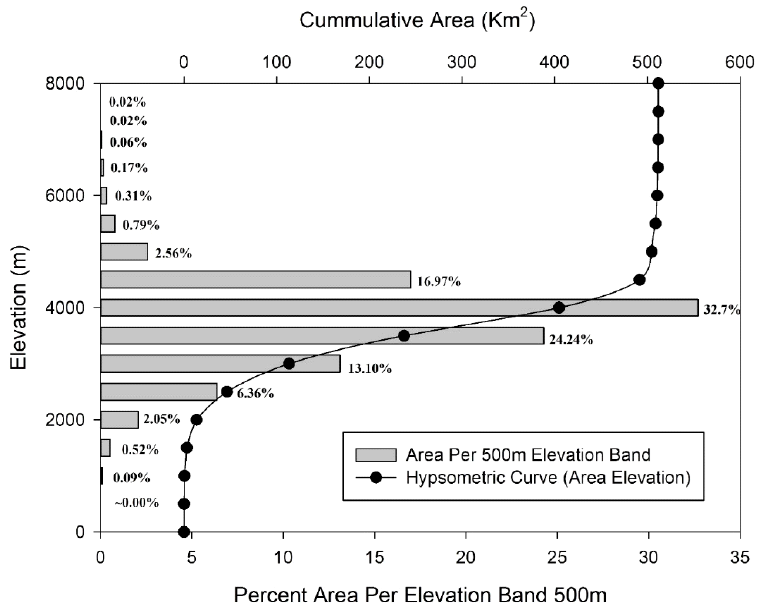
Figure 2. The hypsometric curve of Astore sub-basin of UIB, Pakistan.